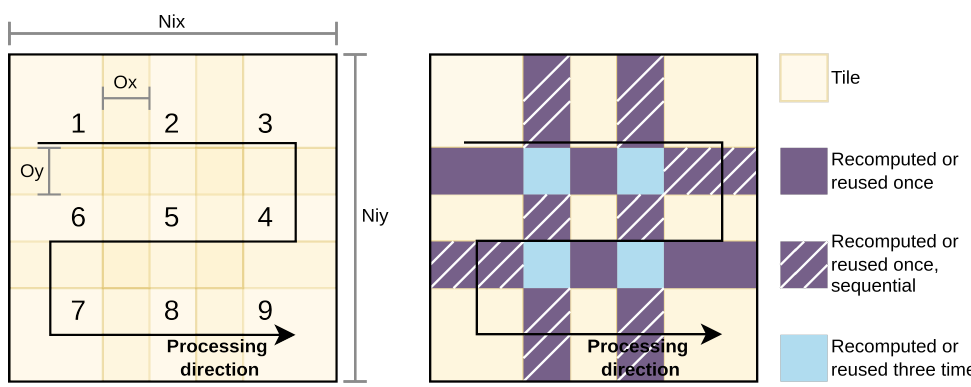
Figure 6. Overlapping regions of adjacent tiles happen during regular processing. In case of single- layer scheduling, these regions would be re-fetched from the main